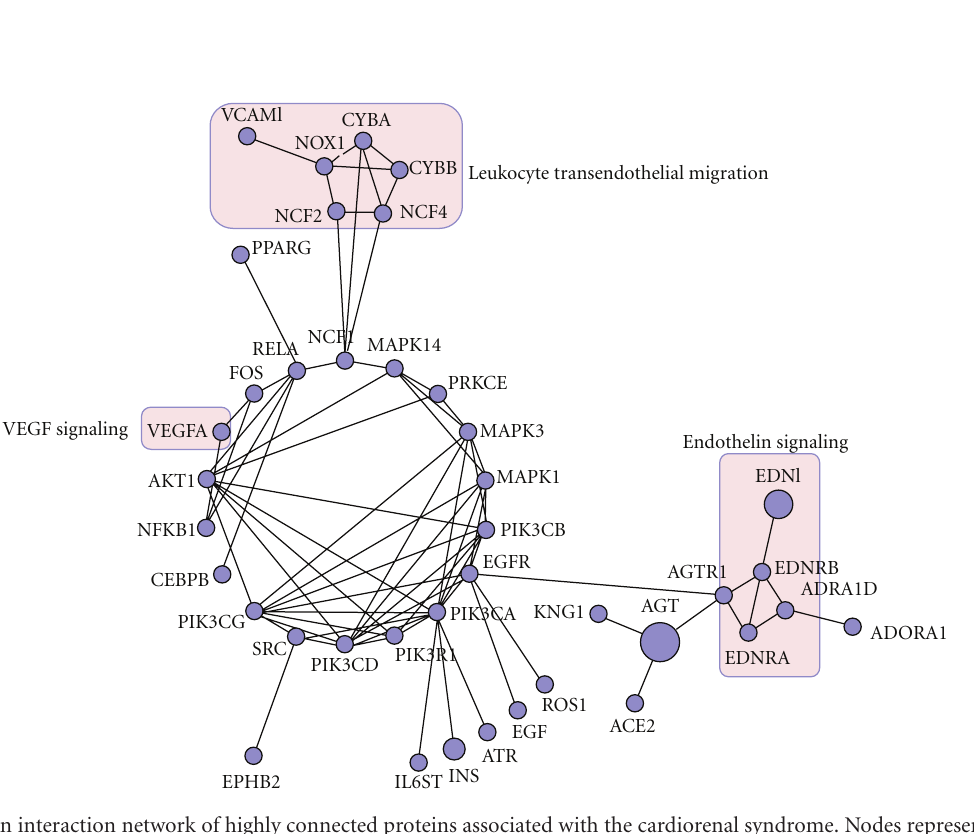
Figure 2: Subcellular location of literature-derived proteins. Presented are categories of subcellular location, the expected number of proteins in a particular category using the total set of human proteins, and the actual number of proteins found as being associated with CRS.